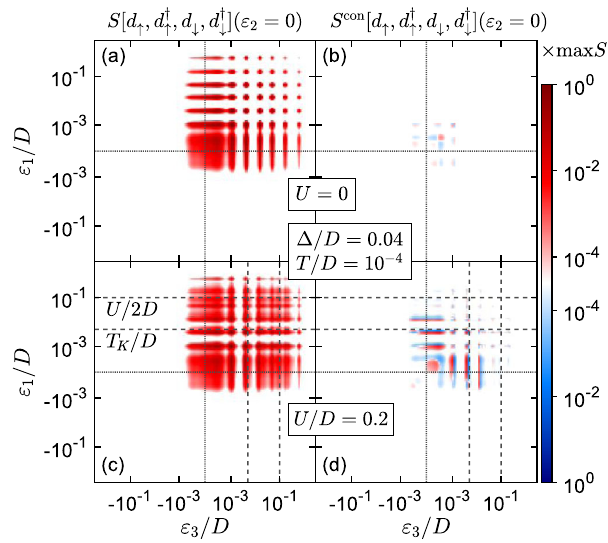
FIG. 2. An exemplary opposite-spin 4 p PSF of the AIM, S ½ d ↑ ; d † ↑ ; d ↓ ; d † ↓ (cid:2)ð ε Þ (out of the 24 PSFs S ), as a function of p ε ε ε 0 . The top and bottom rows show noninteracting 1 and 3 at 2 ¼ ( U ¼ 0 ) and strongly interacting ð U= Δ ¼ 5 Þ cases, the left and right columns the full PSF S and its connected part S con , respectively. For U ¼ 0 , S con should vanish by Wick ’ s theorem; the fact that small but nonzero values remain in (b) is due to numerical artifacts discussed in Sec. VI A. For U ≠ 0 , the distribution of spectral weight reflects the energy scales U= 2 ≃ D= 200 , and S con reveals mutual two-particle correla- and T K tions. These PSFs were computed using Λ ¼ 4 and z ¼ 1 . For visualization, the discrete data were minimally broadened, using the log-Gaussian – Fermi kernel (C1) [24] with narrow width parameters. The intensity values for each row are normalized by the maximum magnitude of S on the